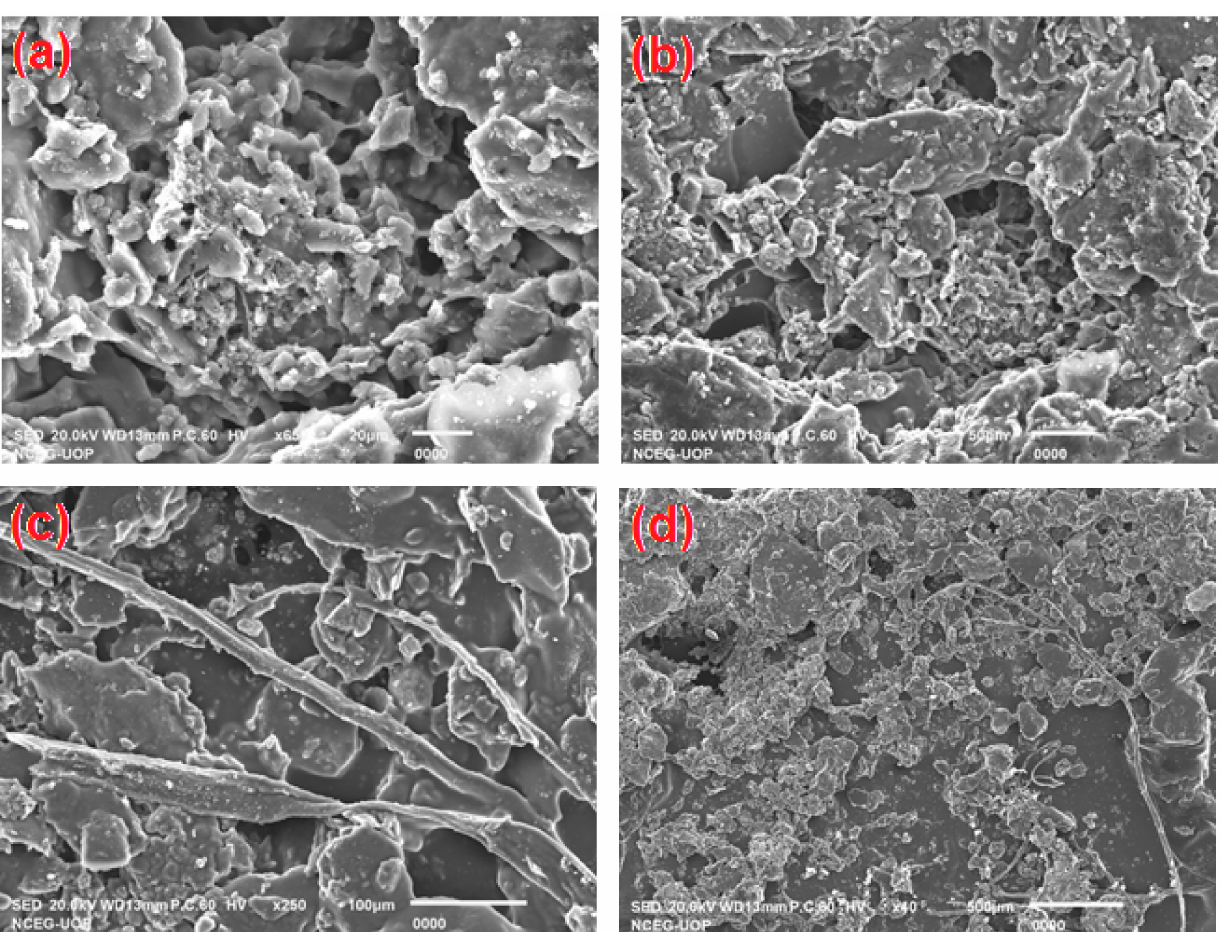
Figure 4. SEM microstructures of Ppy composite sample; ( a ) sample image at 20 µ m, ( b ) sample image at 50 µ m, ( c ) sample image at 100 µ m, ( d ) sample image at 500 µ m showing larger empty